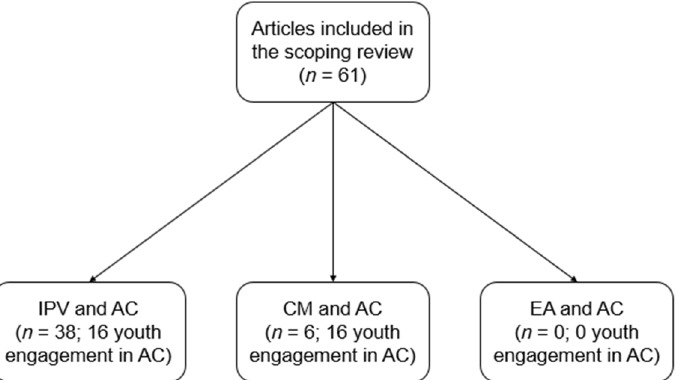
Figure 2. Articles within each category investigated. The categories were not mutually exclusive, so some articles are included in more than one category. Note: IPV = intimate partner violence; AC = animal cruelty; CM = child maltreatment; EA = elder abuse.